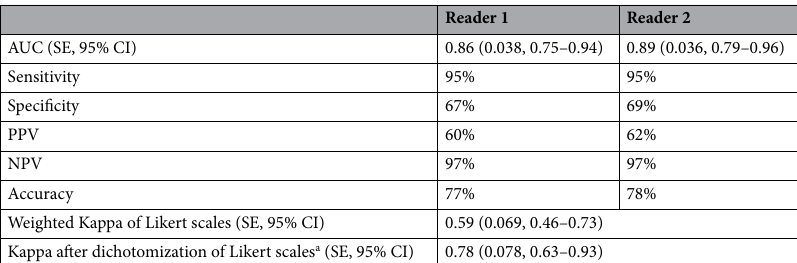
0.78 (0.078, Table 3. Diagnostic performance of the pre-defined MRI system in differentiation of low grade endometrial stromal sarcoma from rare leiomyoma variants. AUC area under the curve, SE standard error, CI confidence interval, PPV positive predictive value, NPV negative predictive value. a Cutoff of Likert scales, > 3.